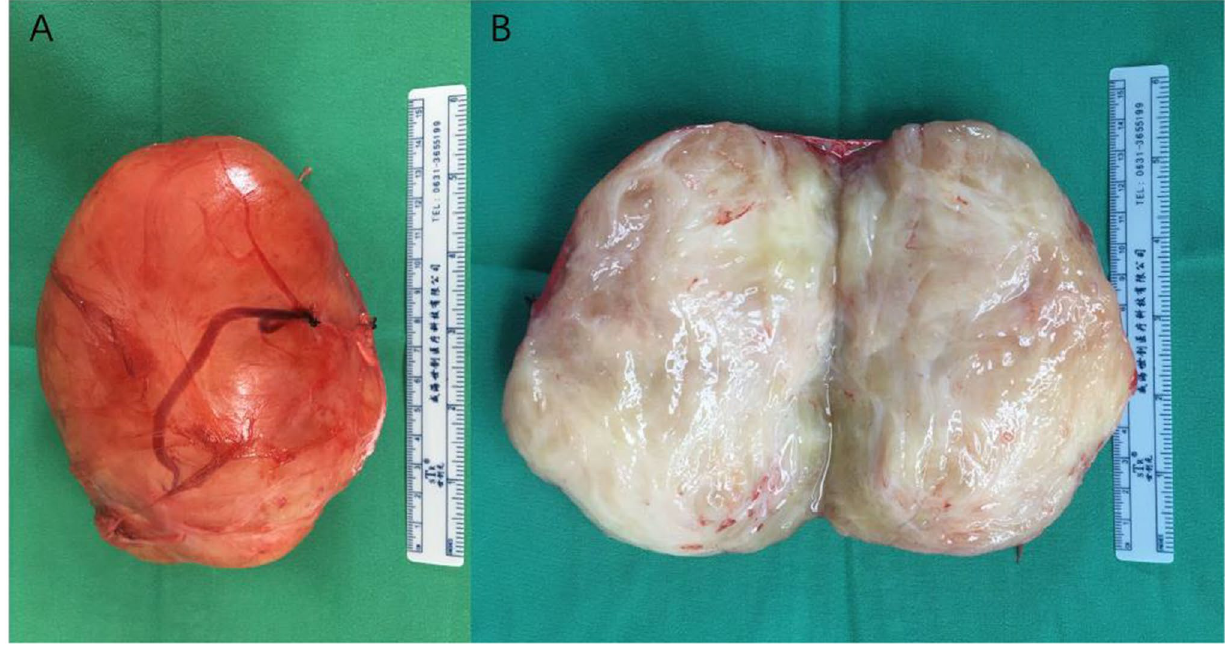
Fig. 2 Excised specimen shows a giant adrenal ganglioneuroma which measured 13 cm × 8 cm × 8 cm. A Gross pathological appearance; B Cross-section appearance of the